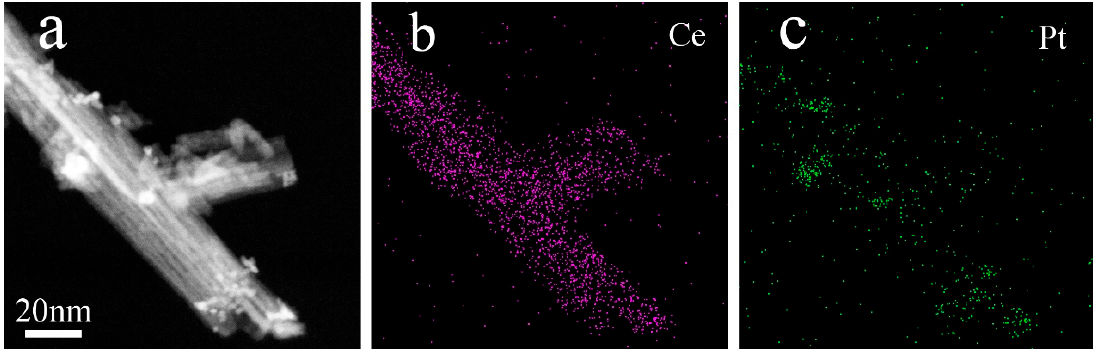
Figure 2. SEM, TEM and selected area electron diffraction (SAED) images of ( a , b , c ) dealloyed Al 91.9 Ce 8 Pt 0.1 , ( d , e , f ) Al 91.7 Ce 8 Pt 0.3 and ( g , h , i ) Al 91.5 Ce 8 Pt 0.5 ribbons calcined at 300 °C. The insert images of ( a , d , g ) are the low magnification SEM images of the samples.